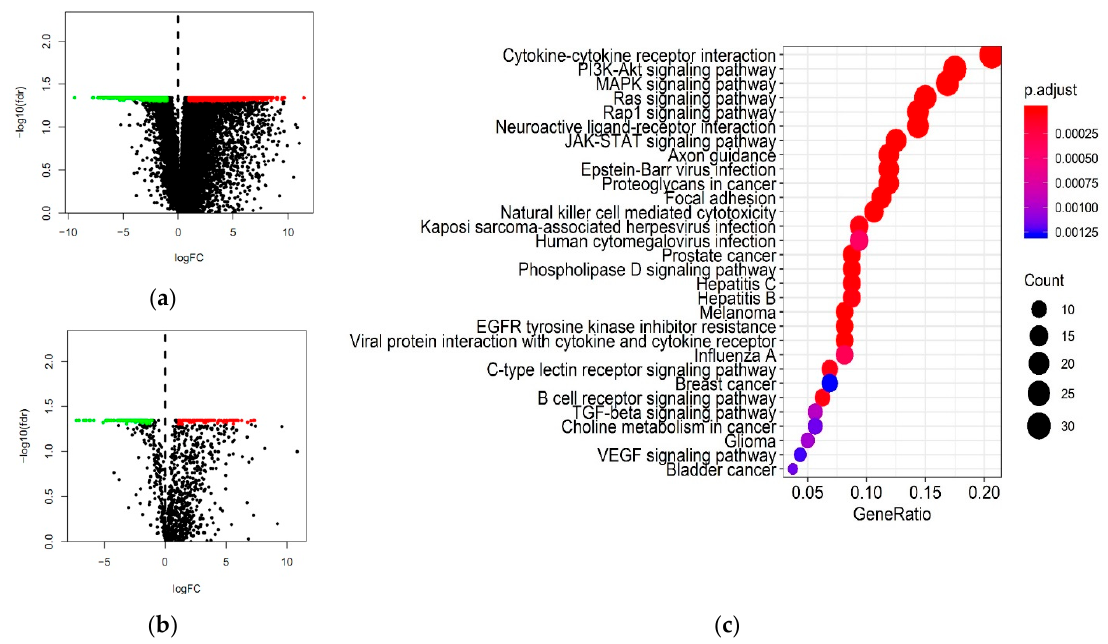
Figure 1. DEGs. ( a ) Volcano plot of DEGs between primary cervical cancer and para ‐ tumor tissues. ( b ) Volcano plot of differentially expressed IRGs. Green dots, down—regulated genes; red dots, up ‐ regulated genes, black dots, no DEGs. ( c ) The results of KEGG analysis. IRGs, Immune—related genes.